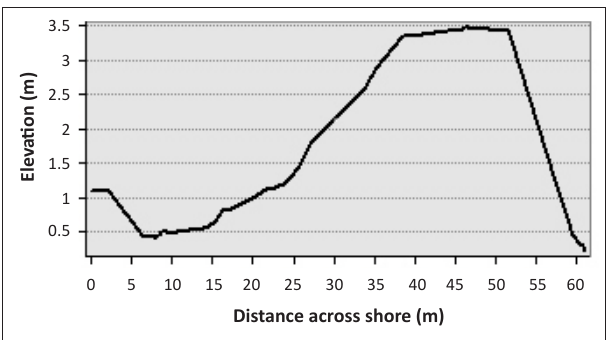
FIGURE 7: Cross-sectional profile of the highest point.